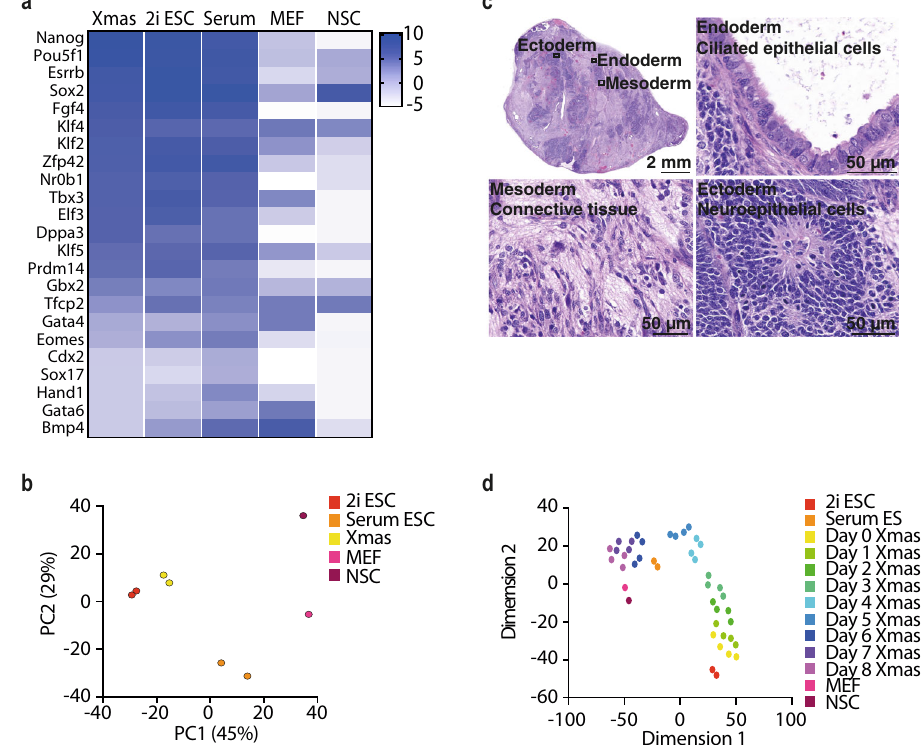
Fig. 3 Xmas mESCs are pluripotent and differentiate as expected. a Heatmap showing average expression (log 2 rpm) of pluripotency genes in Xmas mESCs ( n = 2 independent replicates) and published transcriptomes of mESCs grown in serum or 2i, MEFs or NSCs. b Principle component analysis of RNA-seq data from Xmas mESCs compared with published transcriptomes of mESCs grown in serum or 2i, MEFs or neural stem cells (NSCs). c Representative images of teratomas produced following injection of Xmas mESCs into nude mice ( n = 4 independent replicates), with differentiated cell types from endodermal, mesodermal and ectodermal lineages shown. d tSNE plot comparing the transcriptomes of Xmas mESCs ( n = 4 independent replicates) from day 0 to day 8 of differentiation against published transcriptomes of mESCs grown in serum or 2i, MEFs or